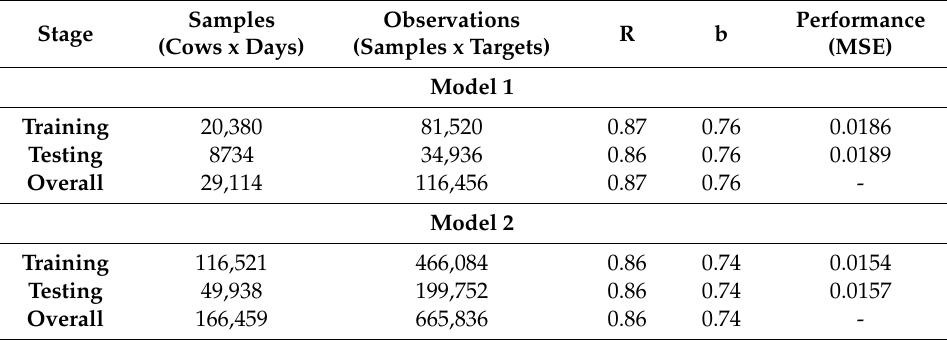
Table 3. Statistical results of each stage of the machine learning